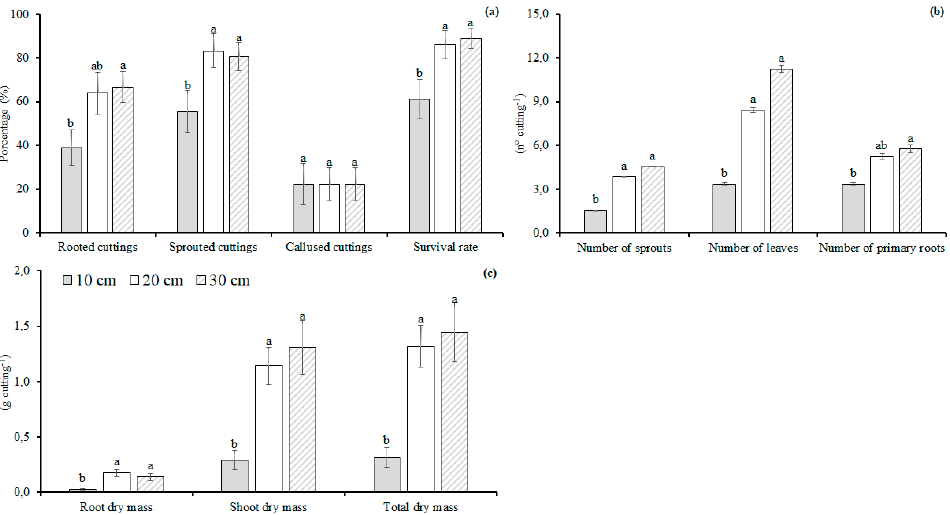
Figure 3. Percentage of rooted, sprouted, and callused cuttings, survival rate ( a ); number of sprouts, leaves, and primary roots ( b ); roots, shoots, and total dry matter ( c ) of Jatropha curcas L. hardwood cuttings with different lengths at 77 days after planting. Different letters above each bar indicate significant differences among the hardwood cuttings with different lengths by the Least Significant Difference (LSD) test at the 5% probability level. Values are represented by the mean of four inde- pendent replicates. The larger hardwood cuttings (30 cm) had a higher percentage of rooting than the smaller cuttings (10 cm) (Figure 3). Around 83% and 81% of the sprouted cuttings were observed for the 20 and 30 cm cuttings, respectively. The smaller cuttings (10 cm) had a lower percentage of sprouted cuttings than the cuttings of 20 and 30 cm in length. There was no influence of cutting length on the percentage of callused cuttings (Figure 4). Over- all, no interaction was observed between the cutting length and part of the branch for the variables at 77 days after the planting. Figure 4. Percentage of rooted, sprouted, and callused cuttings, survival rate ( a ); number of sprouts, leaves, and primary roots ( b ); roots, shoots, and total dry matter ( c ) of Jatropha curcas L. hardwood